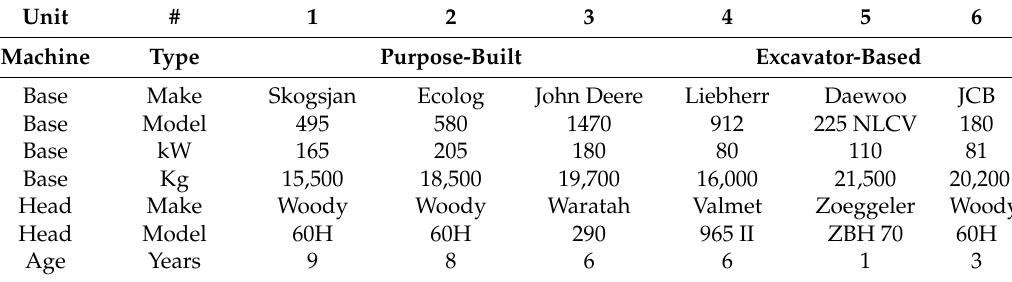
Table 1. Technical characteristics of the machines in the study.